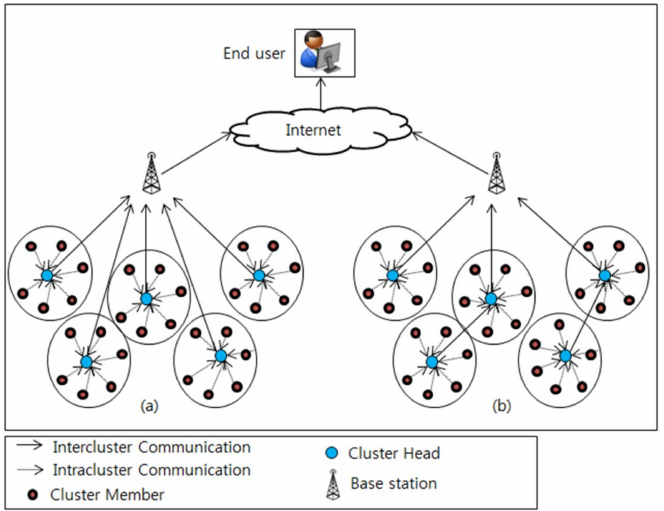
Figure 1. Cluster-based wireless sensor network (WSN) with different data communication scenarios: ( a ) single-hop communication and ( b ) multi-hop communication from sensor nodes to the end user through base station